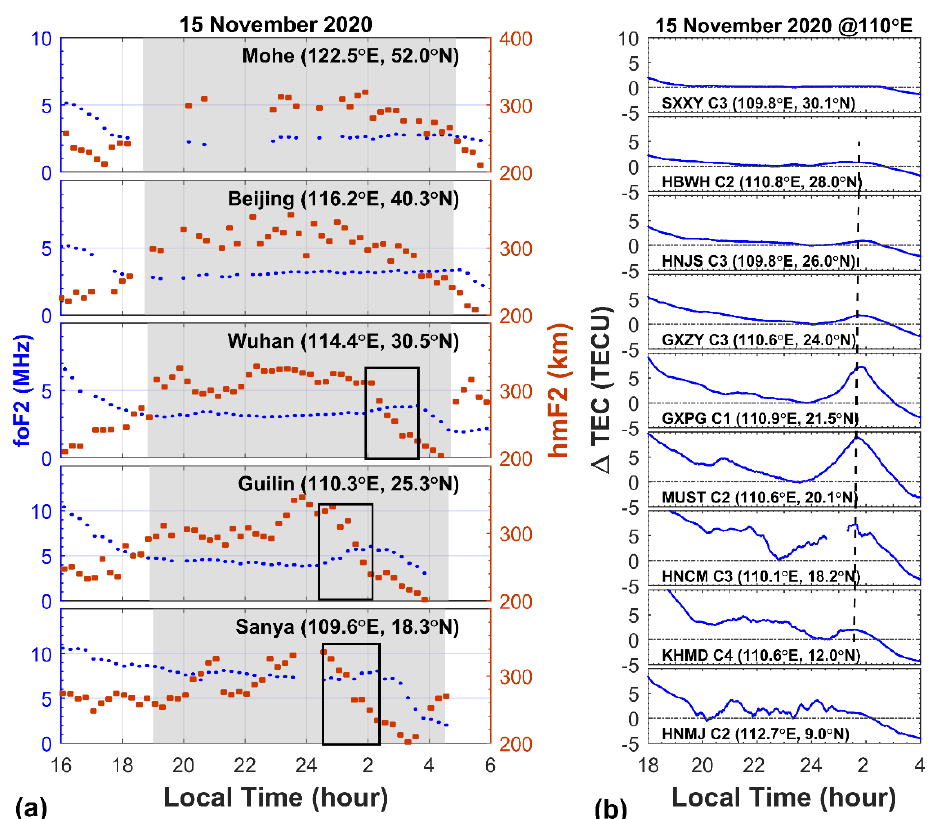
Figure 5. ( a ) Temporal variations of foF2 and hmF2 at Mohe, Beijing, Wuhan, Guilin, and Sanya